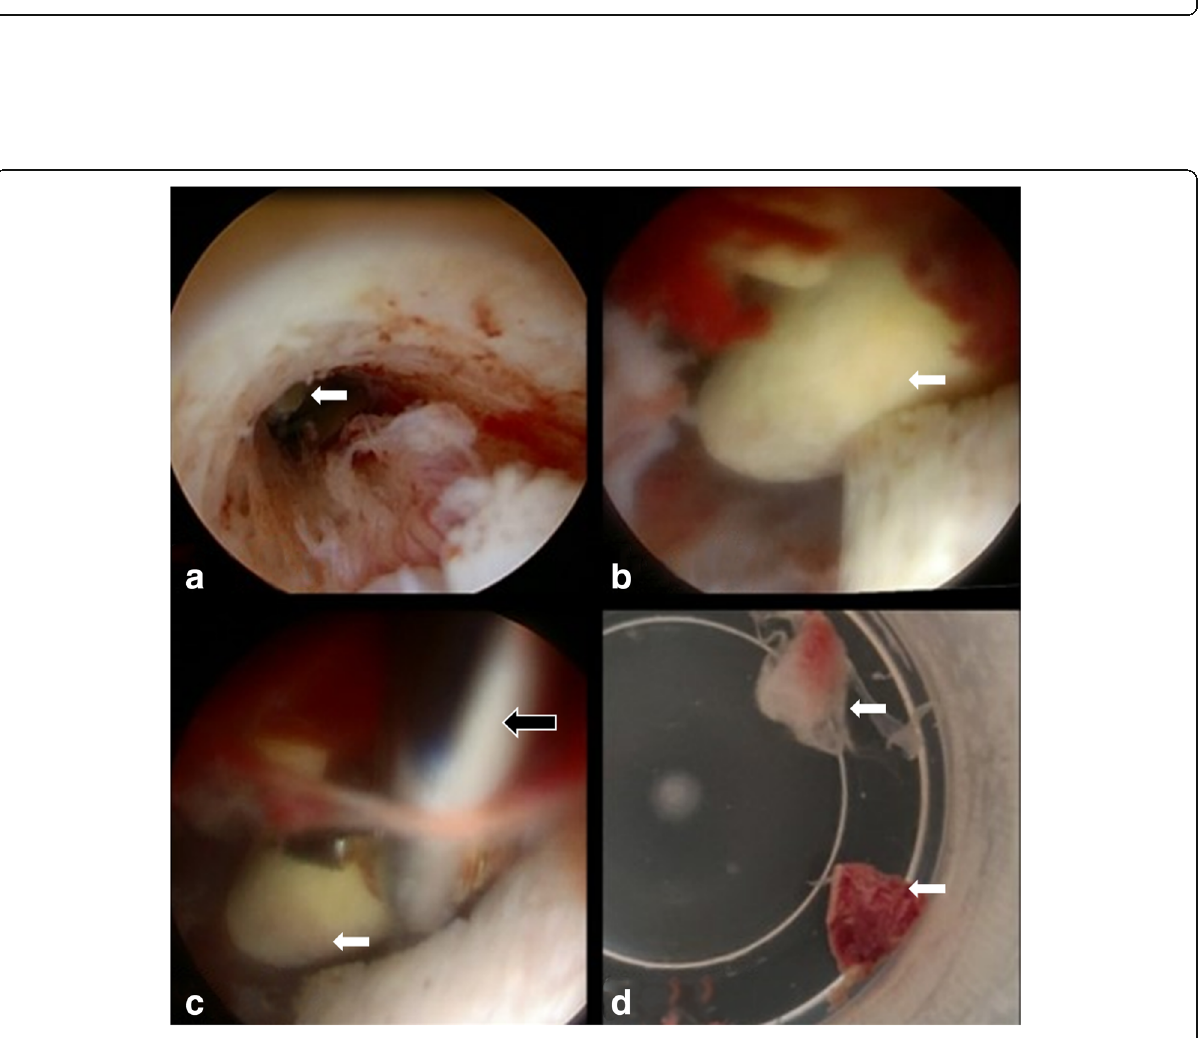
Fig. 6 Serial hysteroscopic images of Fig. 1 patient showing distant ( a ) and close-up ( b ) view of ossified (ivory bone) endometrial tissue (white block arrows). c Hysteroscopy biopsy forceps (black block arrow) within endometrial cavity during retrieval of bony endometrial bits ( d